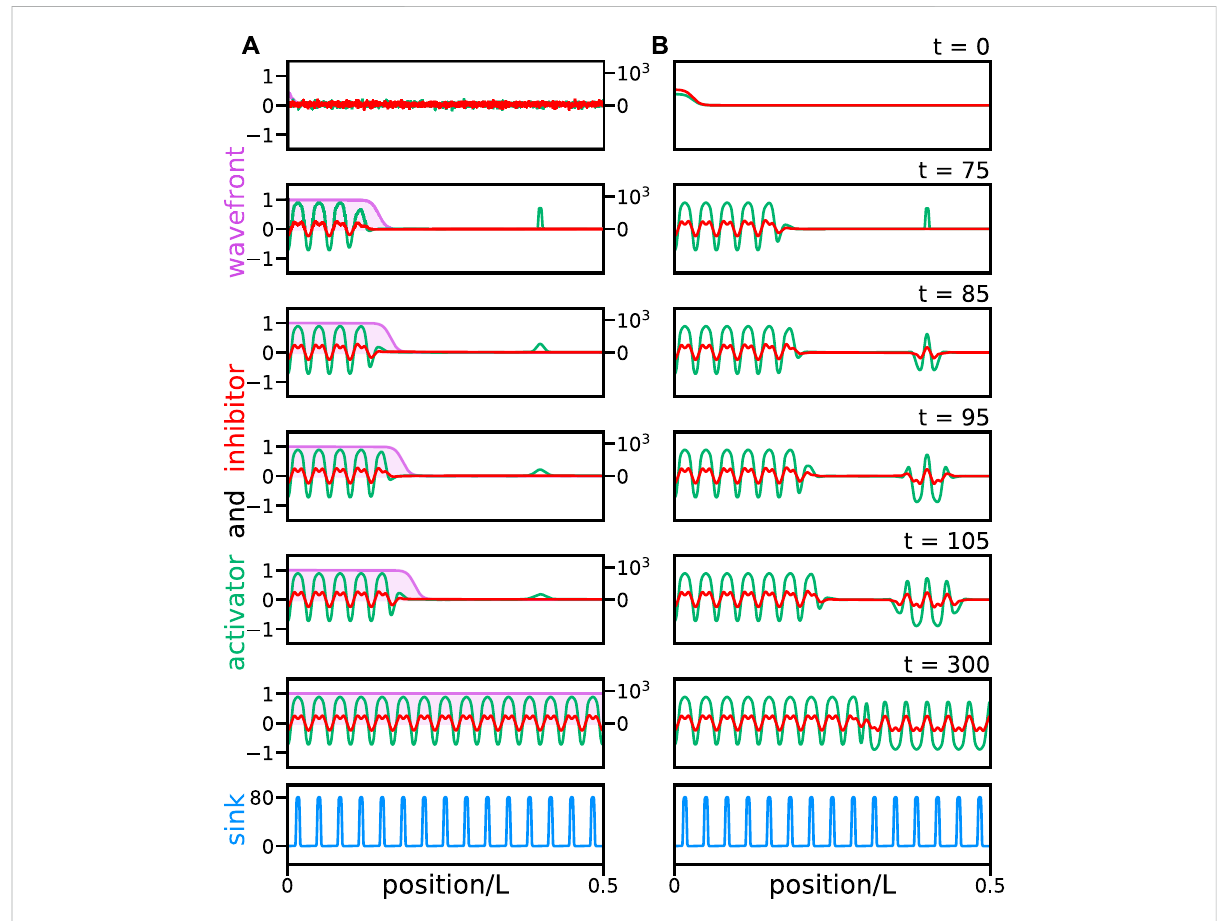
FIGURE 3 A perturbation in the posterior region of the notochord vanishes in a reaction wavefront scenario. Snapshots of solutions (A) of reaction wavefront theory Eqs 15, 16, and (B) Eqs 13, 14 with σ = 0, without a reaction wavefront. A perturbation is introduced in the activator at frame t = 75. ColorcodingandplotlayoutareasinFigure2.Initialconditionsare (A) randomwithmean μ =0.01andstandarddeviation σ 0 =0.05and (B) vanishing except for the anterior perturbation. Other parameters are as in Table 1. Time is expressed in frames and 1 frame ≈ 0 . 0004 time